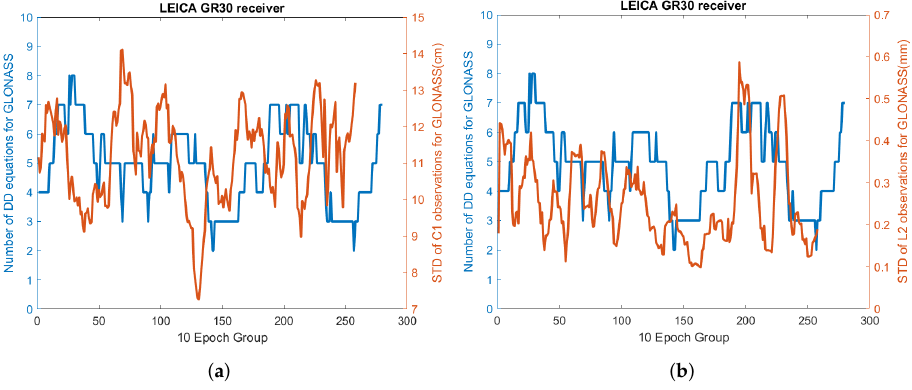
Figure 5. Number of DD equations and the estimated SD for ( a ) C1 and ( b ) L2, for GLONASS in 10 epoch group